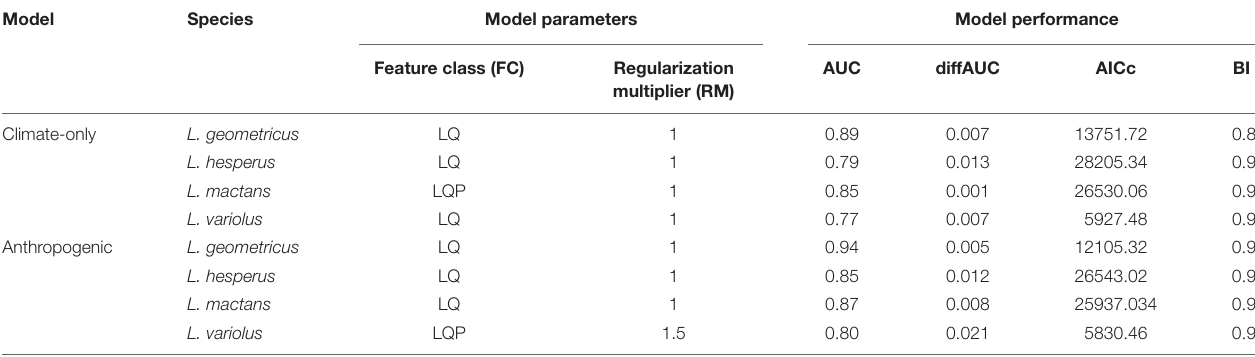
TABLE 2 | Optimal model parameters (feature class, regularization multiplier) and performance metrics (AUC, diffAUC, AICc, BI) for climate-only and anthropogenic models.